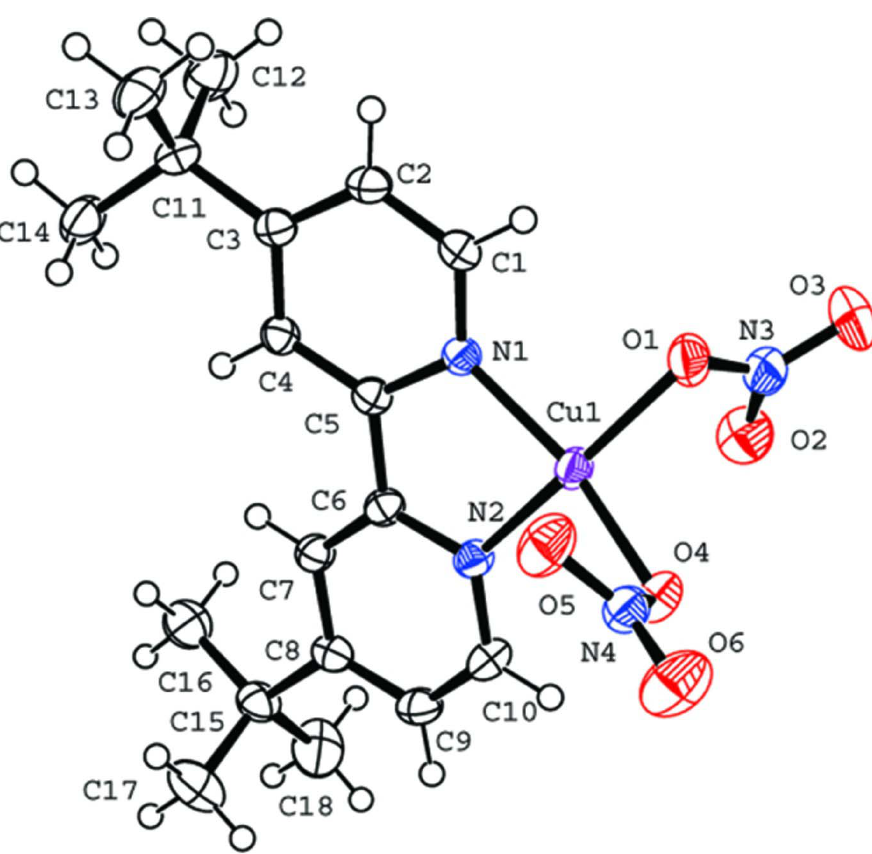
The molecular structure of (I) showing the atom-labelling scheme. Displacement ellipsoids are drawn at the 50% probability